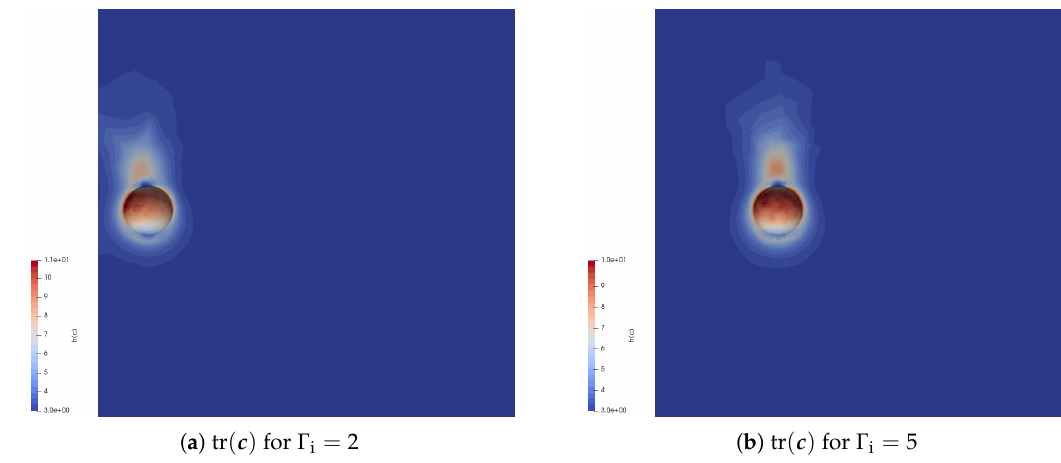
Figure 5. The trace of the conformation tensor around the particle for different initial positions from the inner cylinder at time t / λ = 10 for Λ = 1 and Wi = 0 using S CS